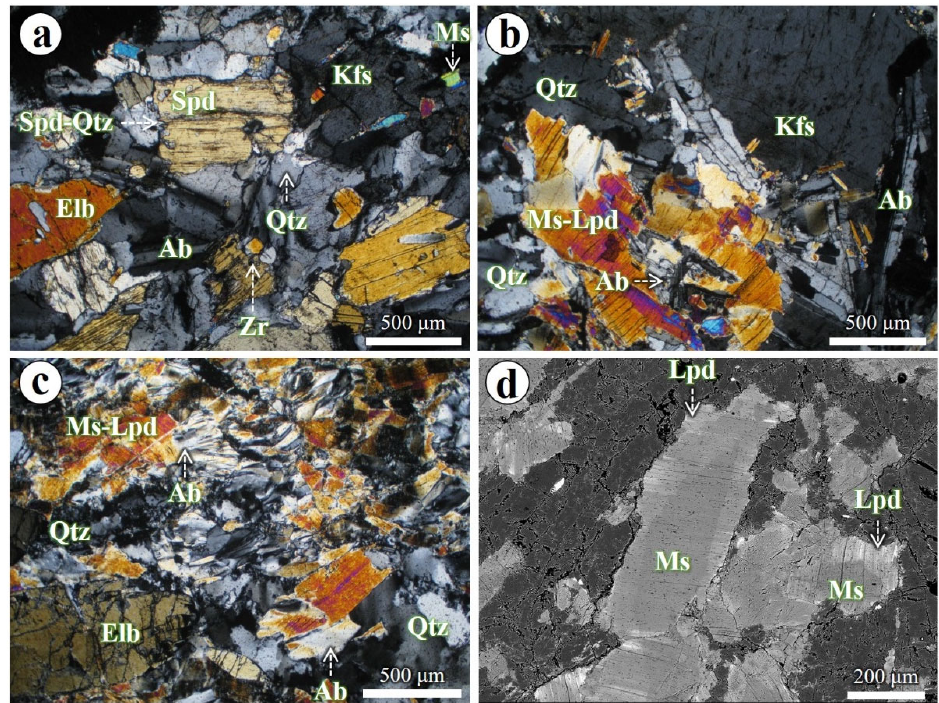
Figure 3. Photomicrograph of Li minerals from the Boam deposit. ( a ) Spodumene intergrowth with magmatic minerals such as K-feldspar, quartz, and plagioclase (albite) (under cross-polarized light). ( b ) K-feldspar replaced by saccharoidal albite (under cross-polarized light). ( c ) Muscovite intergrowth with recrystallized quartz and replacing both K-feldspar and plagioclase (under cross-polarized light). ( d ) Backscattered electron (BSE) image of muscovite-lepidolite. Abbreviations: Ms = muscovite. See Figure 2 for other abbreviations.